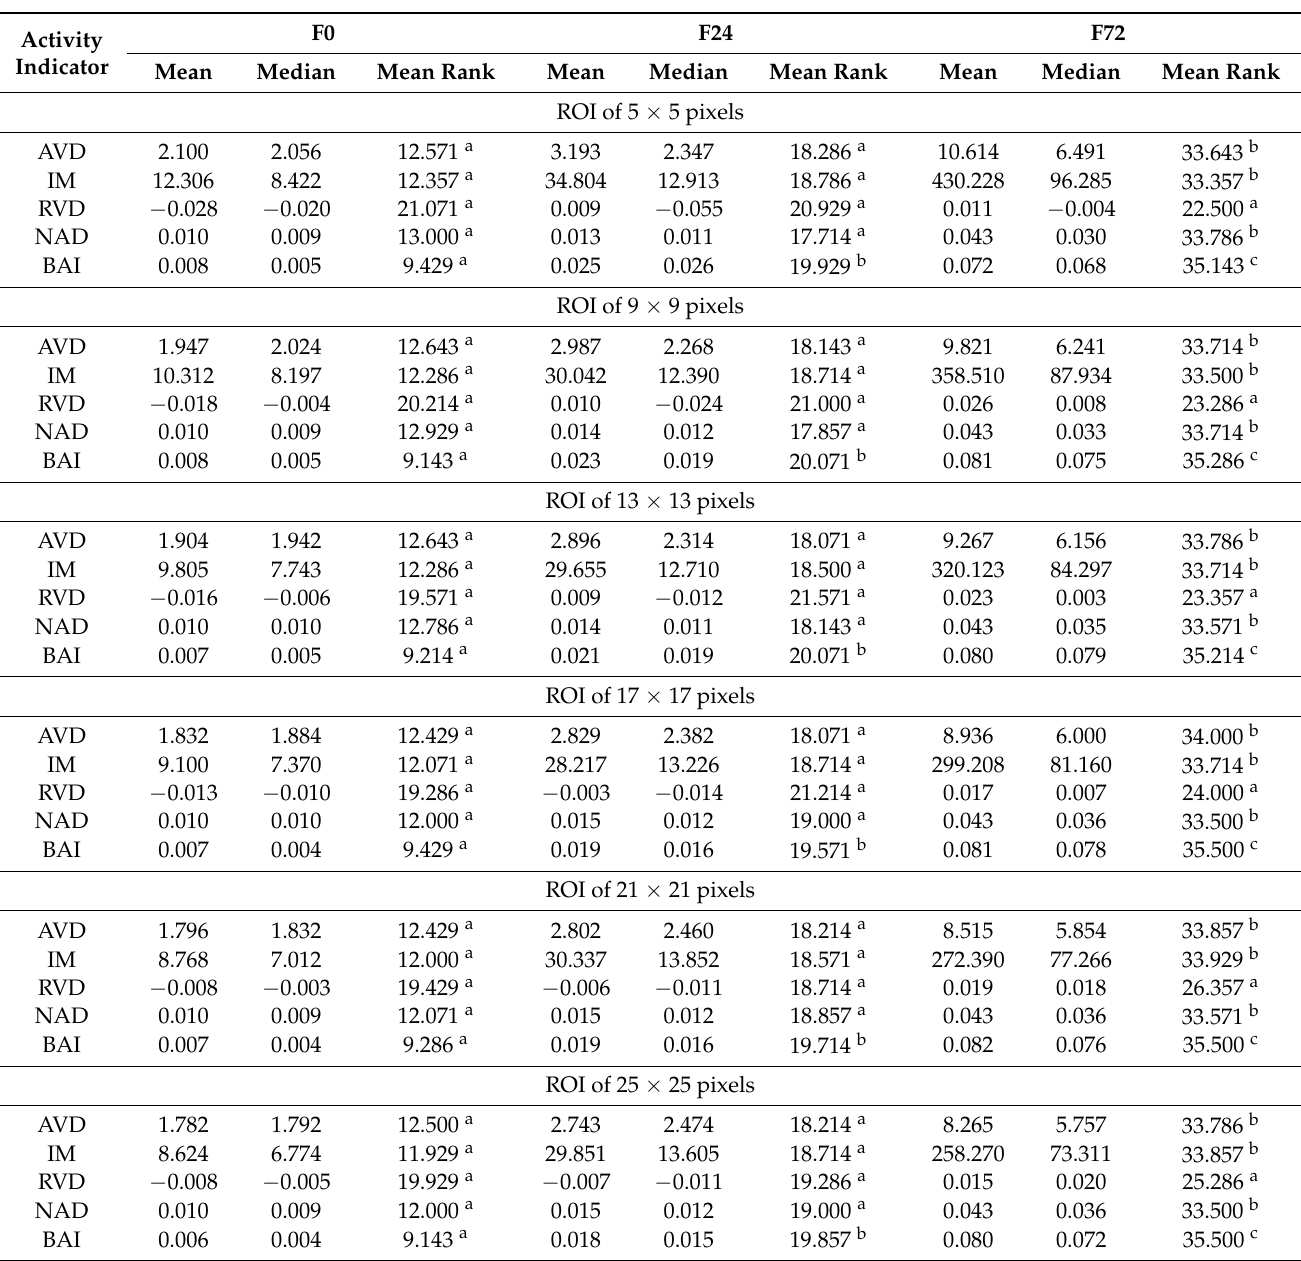
Table 2. Basic statistics for biospeckle indices calculated for THSP obtained from a single column extracted from ROIs of dimensions ranging from 5 × 5 to 25 × 25 pixels with the global maximum in the central